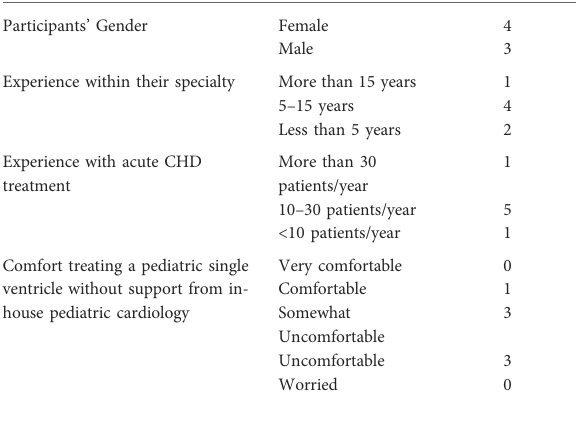
TABLE 3 Ed physician participant